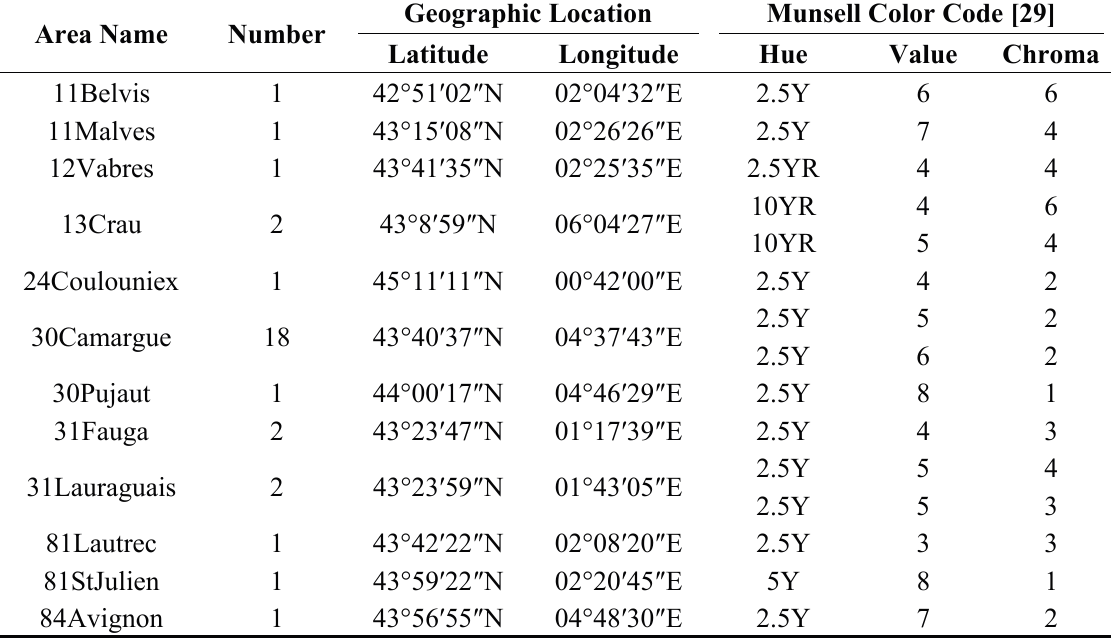
Table 1. Characteristics of the bare soil samples where the area name is defined as [France Department ID][Nearby Town], followed by the number of collected samples, the geographic area location and the corresponding Munsell color code (Y: Yellow; YR: Yellow Red). Extracted from [20].